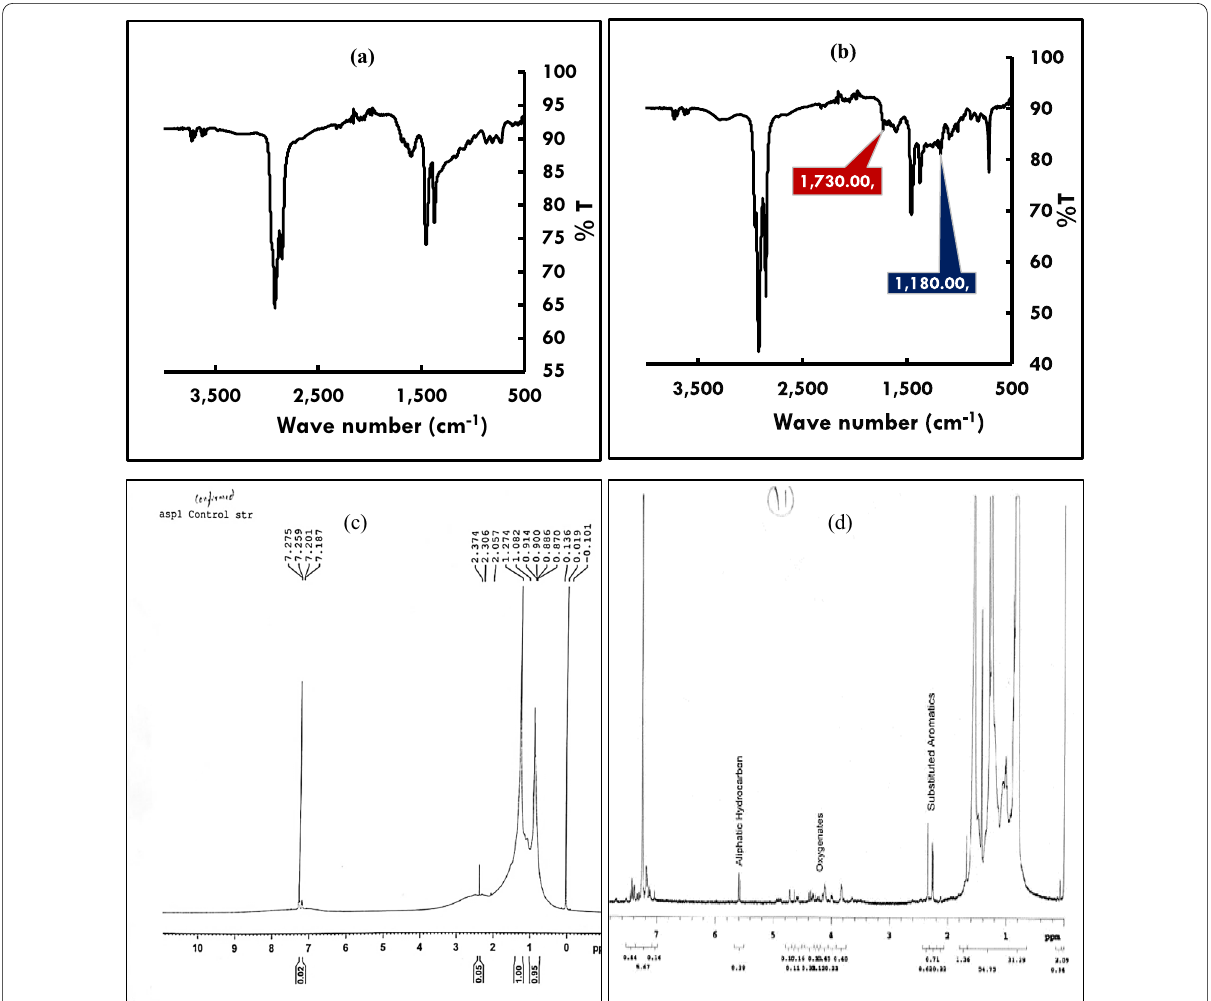
Fig. 3 Changes in the composition of asphaltene due to biotransformation. a FT-IR spectrum of the control asphaltene. b FT-IR spectrum of the biotransformed asphaltene showing incorporation of oxygen in the structure of asphaltene. c 1 H-NMR spectrum (zoomed) of control asphaltene. d 1 H-NMR spectrum (zoomed) of the biotransformed asphaltene showing disappearance of sulfur, nitrogen and formation of oxygenates in the structure of asphaltene due to